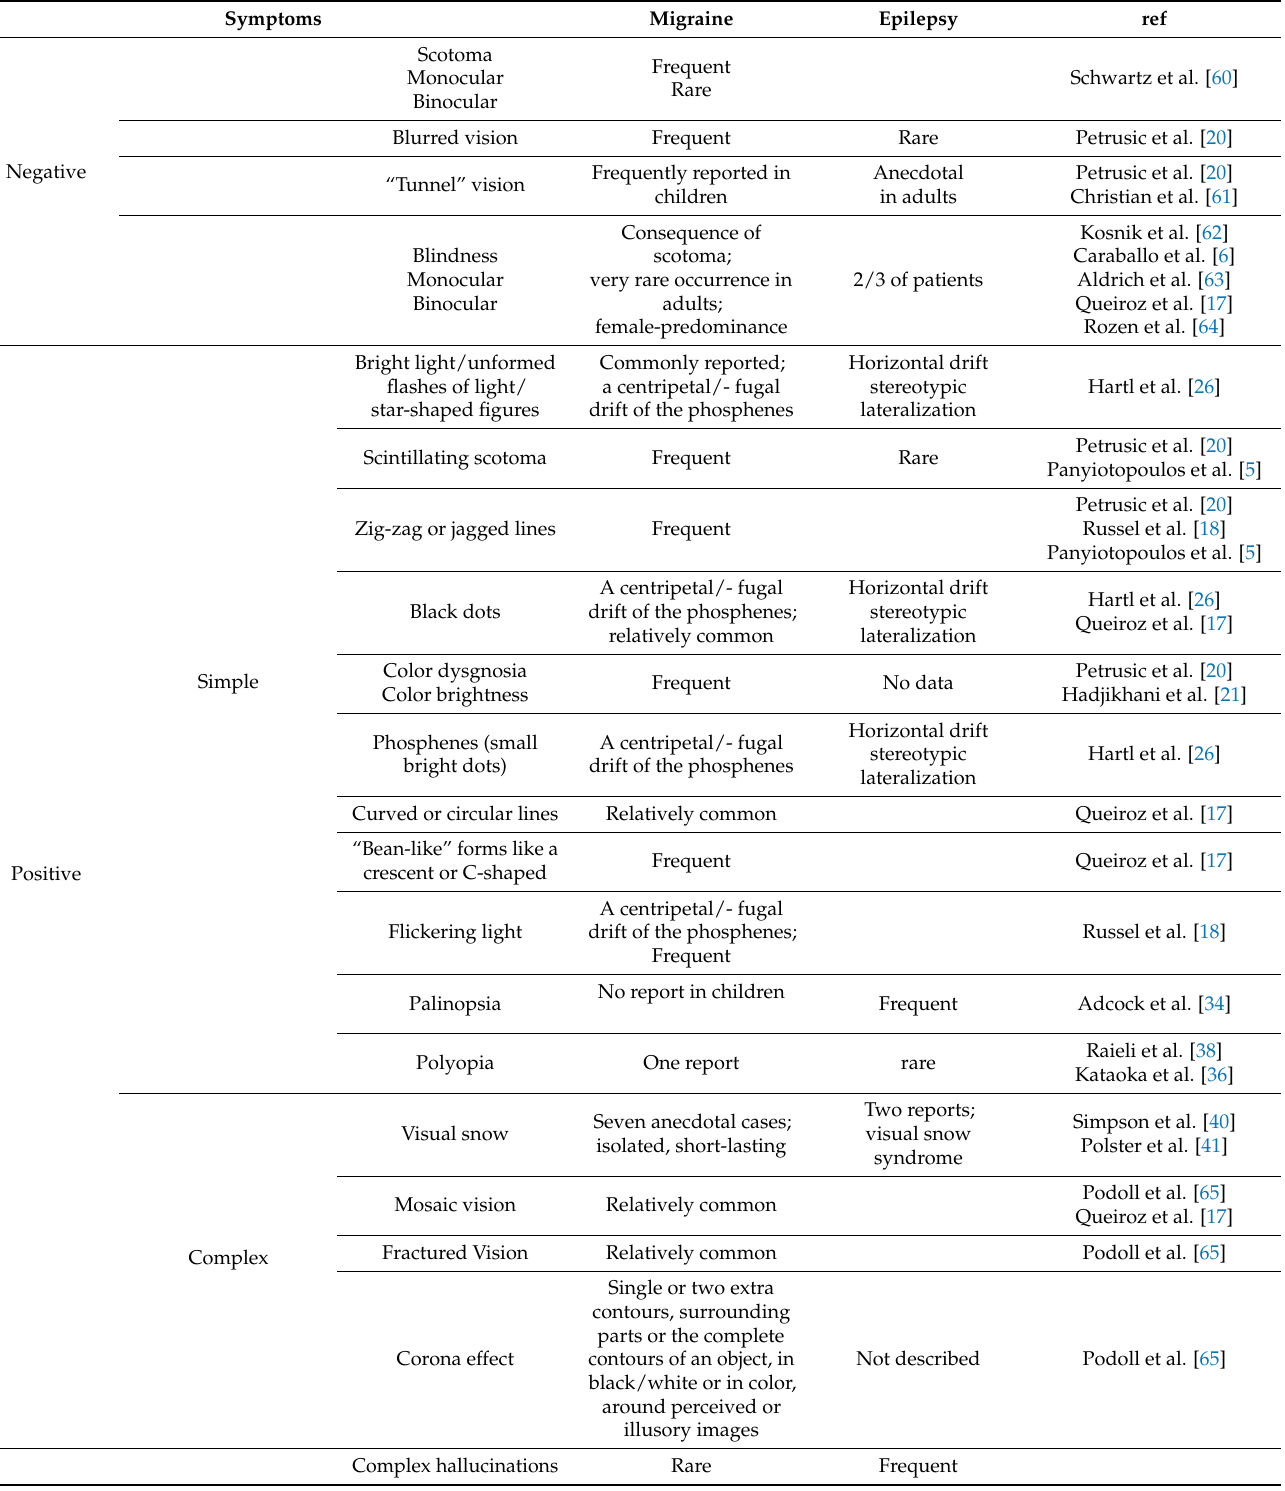
Table 1. Characteristics of visual symptoms: differential diagnosis between migraine and